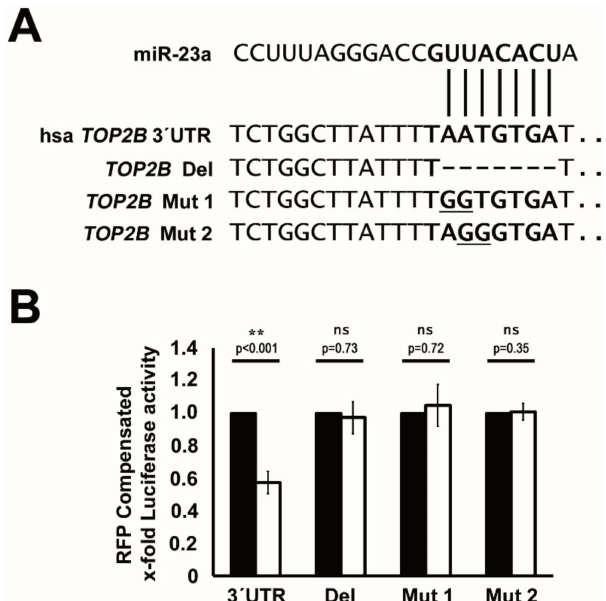
Figure 6. Modulation of TOP2B expression by direct binding of miR-23a in its 3 (cid:48) UTR. ( A ) The sequence of the human TOP2B 3 (cid:48) UTR showing the miR-23a–binding site. Matching base pairs are highlighted by lines. Alteration of the miR-23a binding site by either deletion ( TOP2B Del) or two di ff erent mutations ( TOP2B Mut 1 and Mut 2) is depicted. ( B ) HEK-293 cells were co-transfected with either miR-23a mimic (white bars) or unspecific control (CTRL, black bars), together with luciferase reporter clones, containing (i) wild-type TOP2B 3 (cid:48) UTR (3 (cid:48) UTR), (ii) TOP2B Del (Del), (iii) TOP2B Mut1 (Mut 1), or TOP2B Mut2 (Mut 2). Compensation for di ff erent transfection e ffi ciencies was performed by co-transfection of pCS2-RFP. Graphs demonstrate the mean luciferase activity (RFP-compensated) of three independent experiments ± SD; values are given as the x-fold expression of the respective control-transfected setting. Statistical significance between IC 50 values was calculated using Student’s t